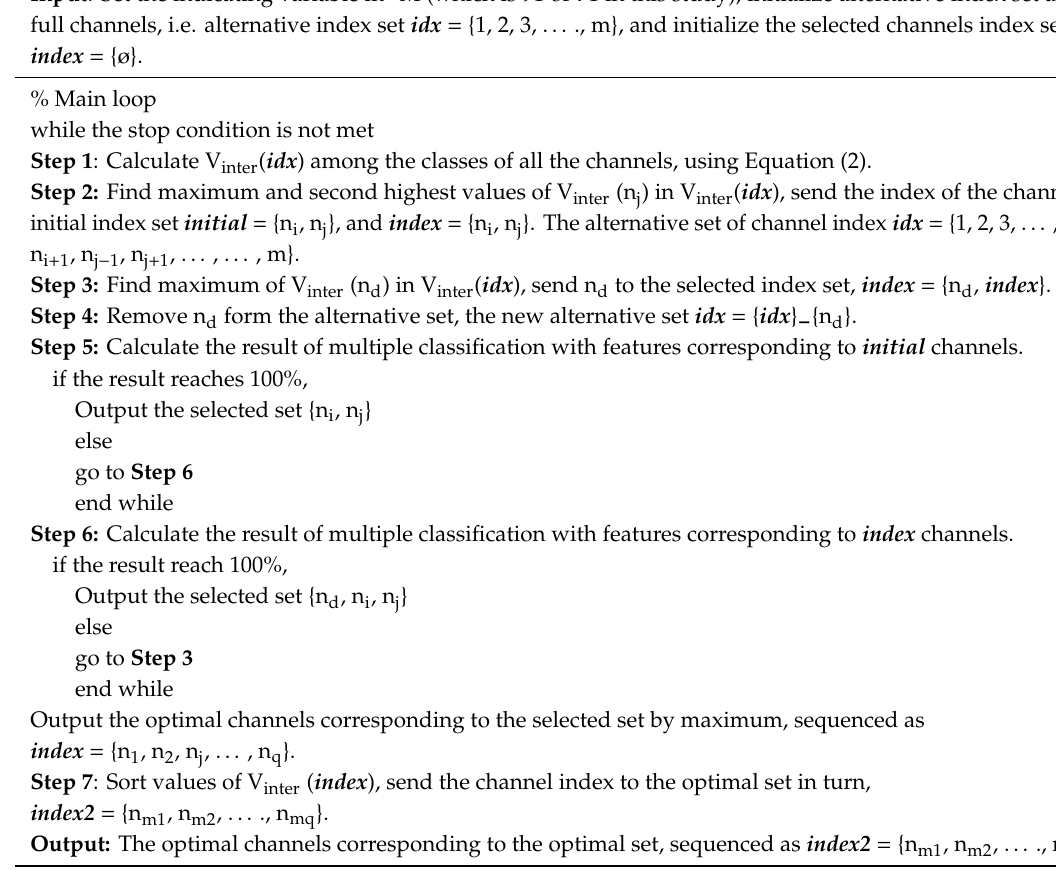
Method 1. Pseudo Code of the Proposed